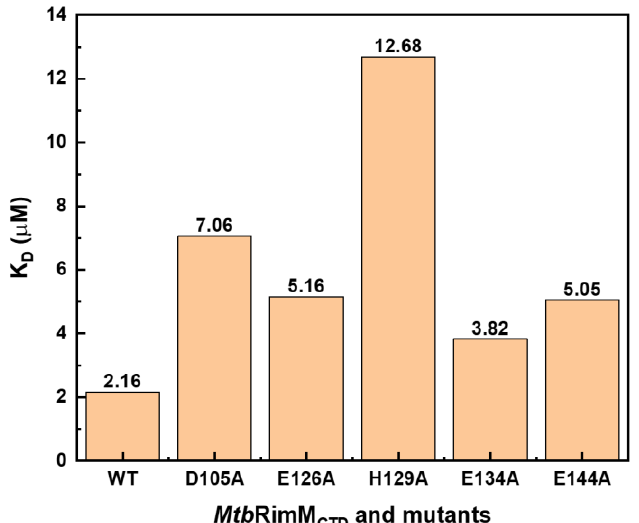
Figure 10. Dissociation constants (K D ) of wild-type (WT) Mtb RimM CTD and its mutants for binding Mtb S19 determined by SPR affinity assays.